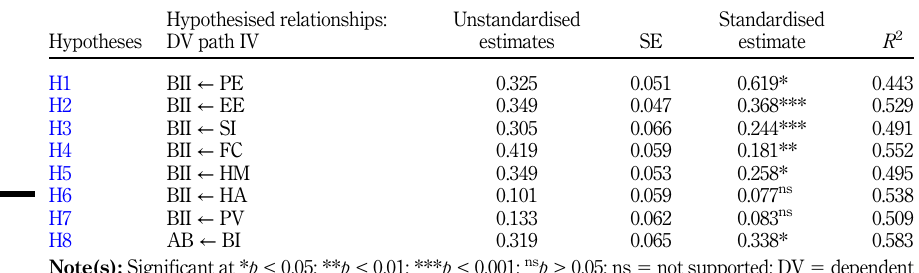
Table 7. Test of